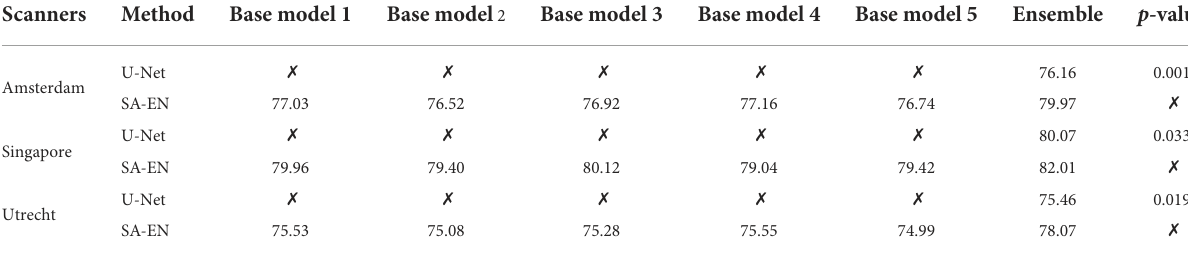
TABLE 6 Performance (Dice, %, higher is better) of SA-EN on three different scanners in the MICCAI dataset, respectively.